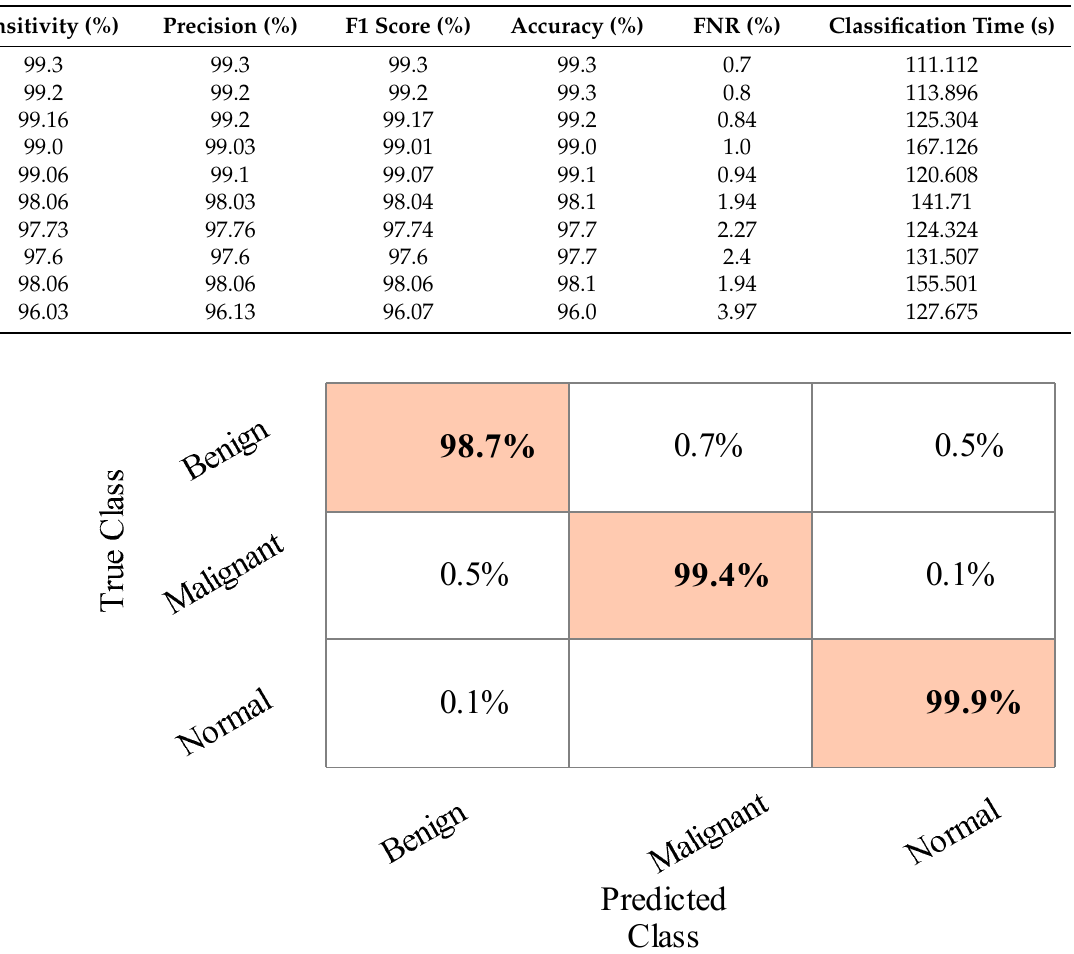
best accuracy obtained at 98.9% for Cubic SVM. The MGSVM and Q-SVM obtained the second-best accuracy of 98.7%. The rest of the classifiers such as ESD, LSVM, ESKNN, FKNN, LD, CGSVM, and WKNN, and their accuracy values are 98.7%, 98.6%, 98%, 97.8%, 98.1%, 97.9% and 97.2%, respectively. The confusion matrix of Cubic SVM is illustrated in Figure 8. In addition, the computational time of each classifier is also noted, and the best time is 76.2 (s) for Cubic SVM and the worst time is 107.679 (s) for the ESKNN classifier. The accuracy of classifiers from experiments (i)–(iii) using different training/testing ratios better than the rest of the selected